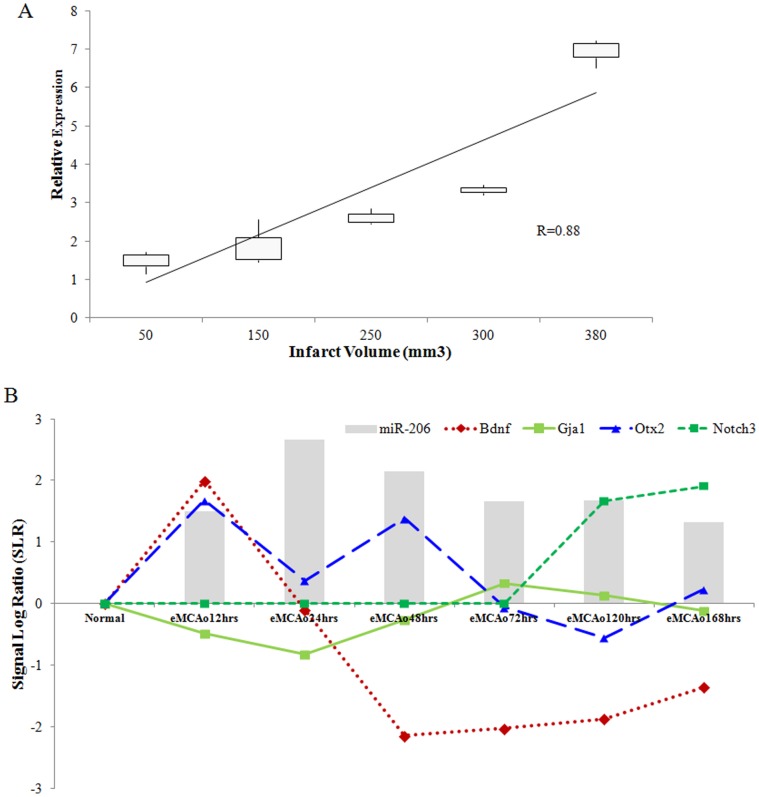
miR-206 correlated with increased cell death in vivo.(A) MiR-206 expression as validated by qRT-PCR in an independent cohort of eMCAo models with varying infarct sizes. (B) Expression of miR-206 and its target mRNA (Gja1, Notch3, Otx2 and Bdnf) in rat brain subjected to MCAo. Inverse correlation was observed between miR-206 and Bdnf, Notch3, Otx2 and Gja1.